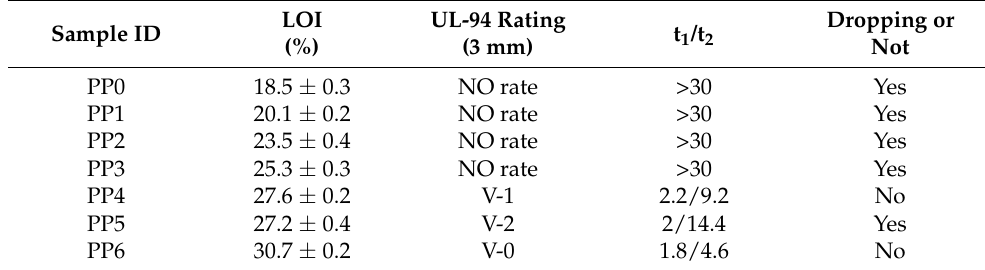
Table 2. Detailed results for PP and its flame-retardant composites from UL-94 and LOI tests.